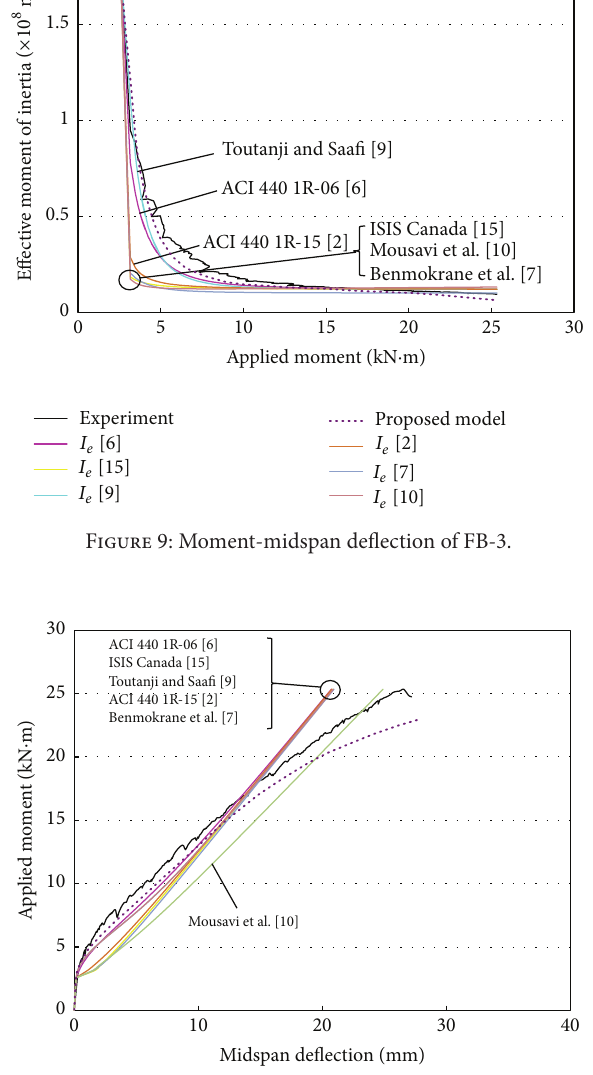
did not represent the tension-stiffening effect of the test specimens until around half of the ultimate strength. The reason may be that the equations evaluate the effective moment inertia to be much less than that of the test specimen until the loading stage, and then they respond with a linearly hardening prediction until ultimate strength. The proposed model, however, represented the moment- deflection response well, even the nonlinear behavior, until ultimate